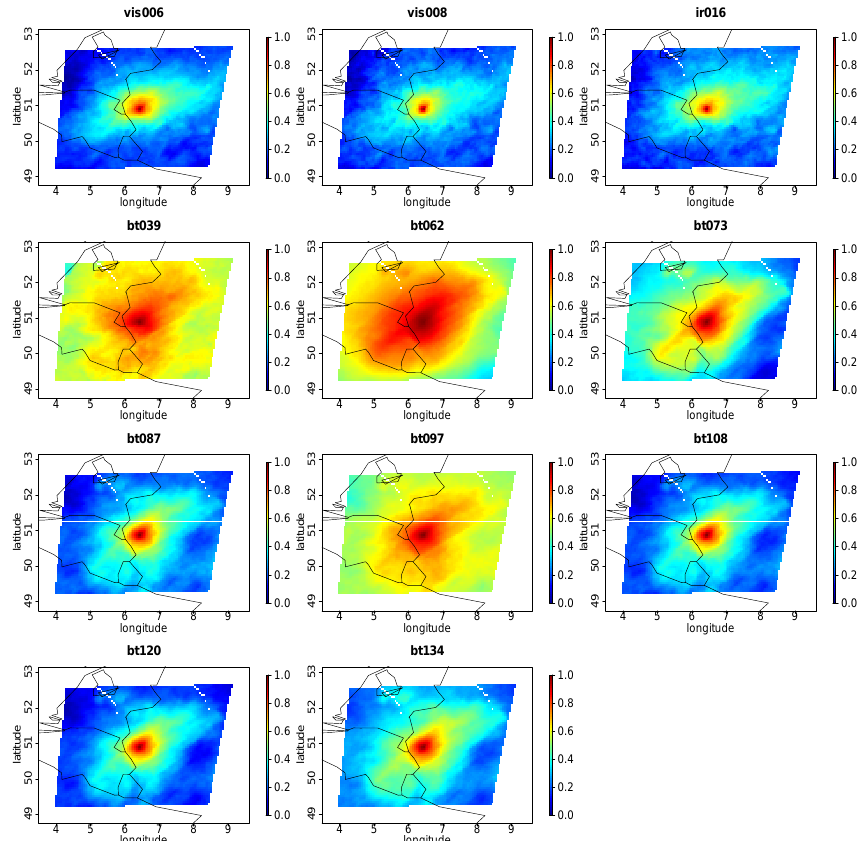
Figure 4. Same as Fig. 3 but for half covered cases from the year